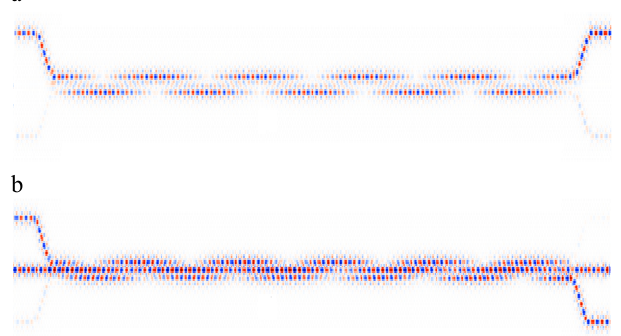
Figure 7: Snapshots of the probe signal at the wavelength of 1.55 µ m propagating down the PhC directional coupler switch when (a) no control signal is launched (linear case) and (b) a control signal at the wavelength of 1.3 µ m is launched (nonlinear case).